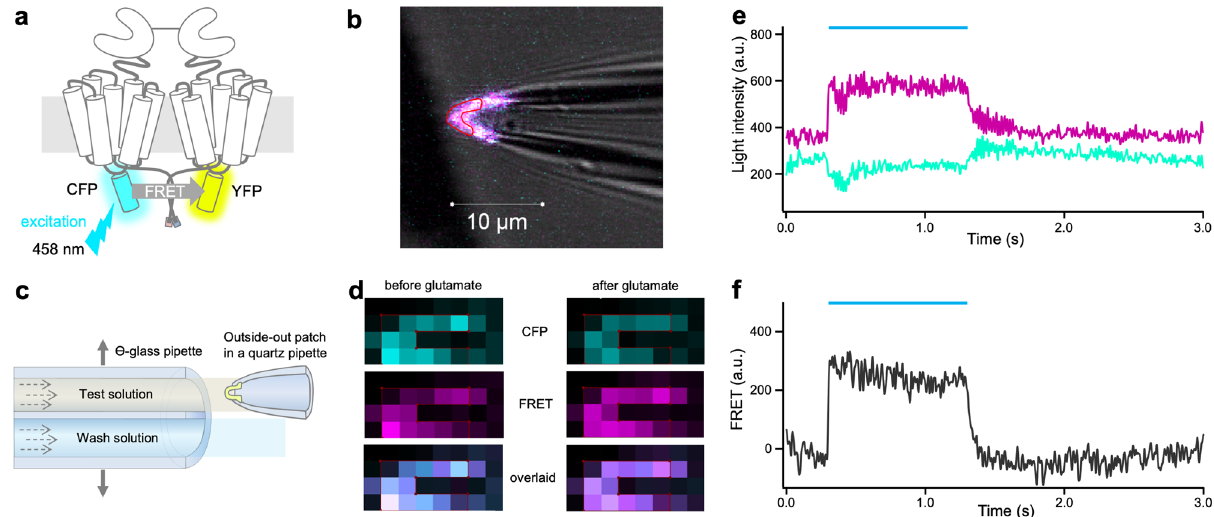
Fig. 2 Kinetic FRET measurements in outside-out patches. a Cartoon illustrating the principle of FRET measurements by exciting the donor CFP at 458 nm and detecting the emissions of CFP and YFP. b Tip of a patch pipette carrying an outside-out patch containing a large number of labeled homodimeric mGluR1. c Scheme illustrating fast solution switches at the outside-out patch. A double-barreled Θ -glass pipette delivering two laminar streams of solutions is stepped by a piezo device. d Confocal images of a patch before and after adding glutamate. Left panels show signals coming from CFP, FRET, and overlaid channels before adding glutamate. The right panels show a decreased CFP signal, increased FRET signal, and a clear signal change in the overlaid channel, presumably due to a conformational change. e Fluorescence signal and glutamate-induced changes in time-dependent traces of YFP (magenta) and CFP (cyan) after correction for crosstalk and photobleaching. The light blue bar indicates the application of glutamate (1 mM). f Calculated FRET signal from e